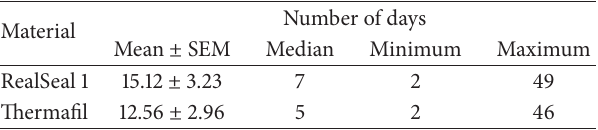
Table 1: Mean number of days from bacterial inoculation to microleakage of teeth filled with RealSeal 1 and Thermafil.